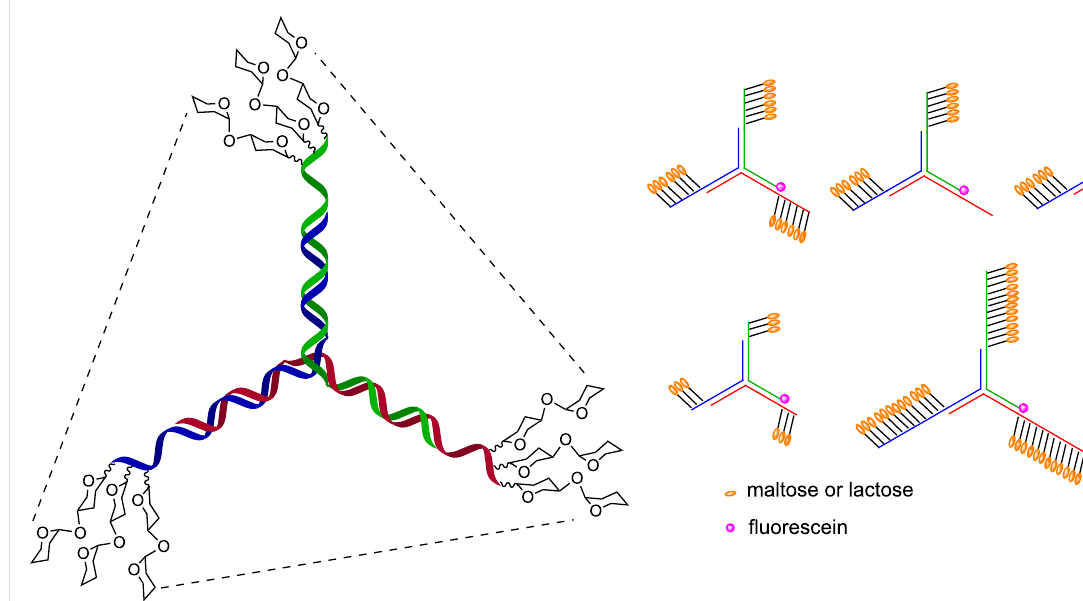
Figure 2: Multivalent triangular glycoDNA assemblies.